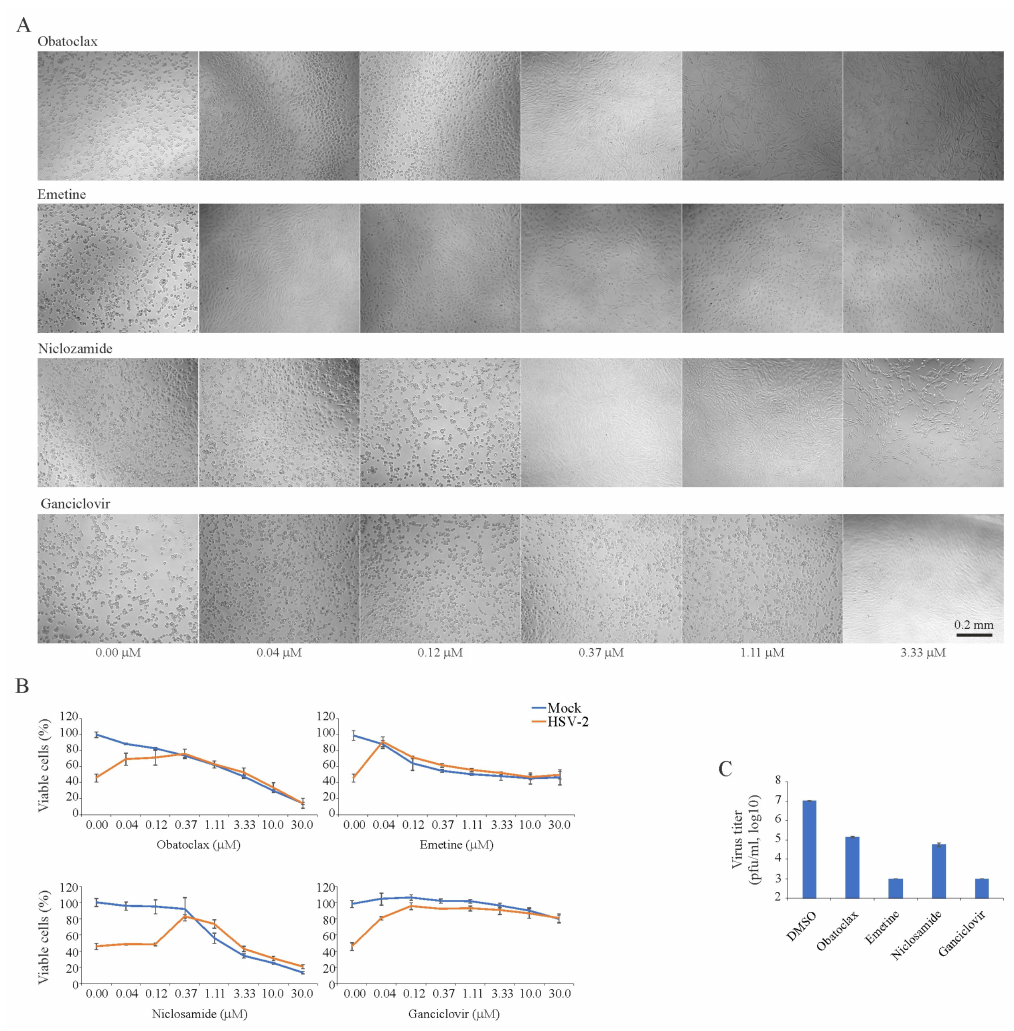
Figure 2. E ff ect of obatoclax, emetine, niclosamide and ganciclovir on the viability of mock- and herpes simplex virus type 2 (HSV-2)-infected retinal pigment epithelial (RPE) cells and the production of infectious virus particles in these cells. ( A ) RPE cells were treated with increasing concentrations of a compound and infected with HSV-2 (moi, 0.1). Cells were imaged after 72 h in the phase-contrast mode. ( B ) RPE cells were treated with increasing concentrations of a compound and infected with mock- or HSV-2 (moi, 0.1). The viability of the cells was determined to be 72 hpi with the CTG assay. Mean ± standard deviation (SD); n = 3 (experimental replicates). ( C ) HSV-2 production in RPE cells treated with obatoclax (0.12 µ M), emetine (0.04 µ M), niclosamide (0.37 µ M), ganciclovir (3.33 µ M) or DMSO-treated as measured by plaque assay using A549-Npro cells (Mean ± SD; n =